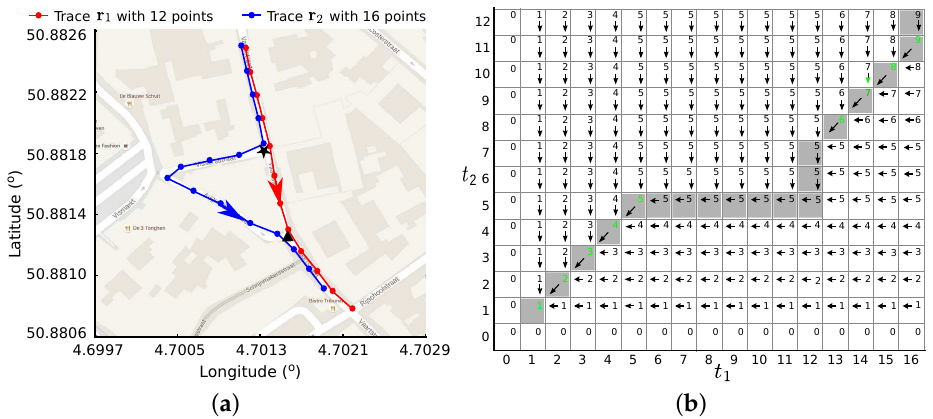
Figure 1. An example of two GNSS traces sharing two road segments. ( a ) two GNSS traces, which diverge at the star intersection from one common road segment onto two different road segments, then converge to another common road segment at the triangle intersection; ( b ) the length and direction matrices used in the Longest Common SubSequence (LCSS) procedure to find the common